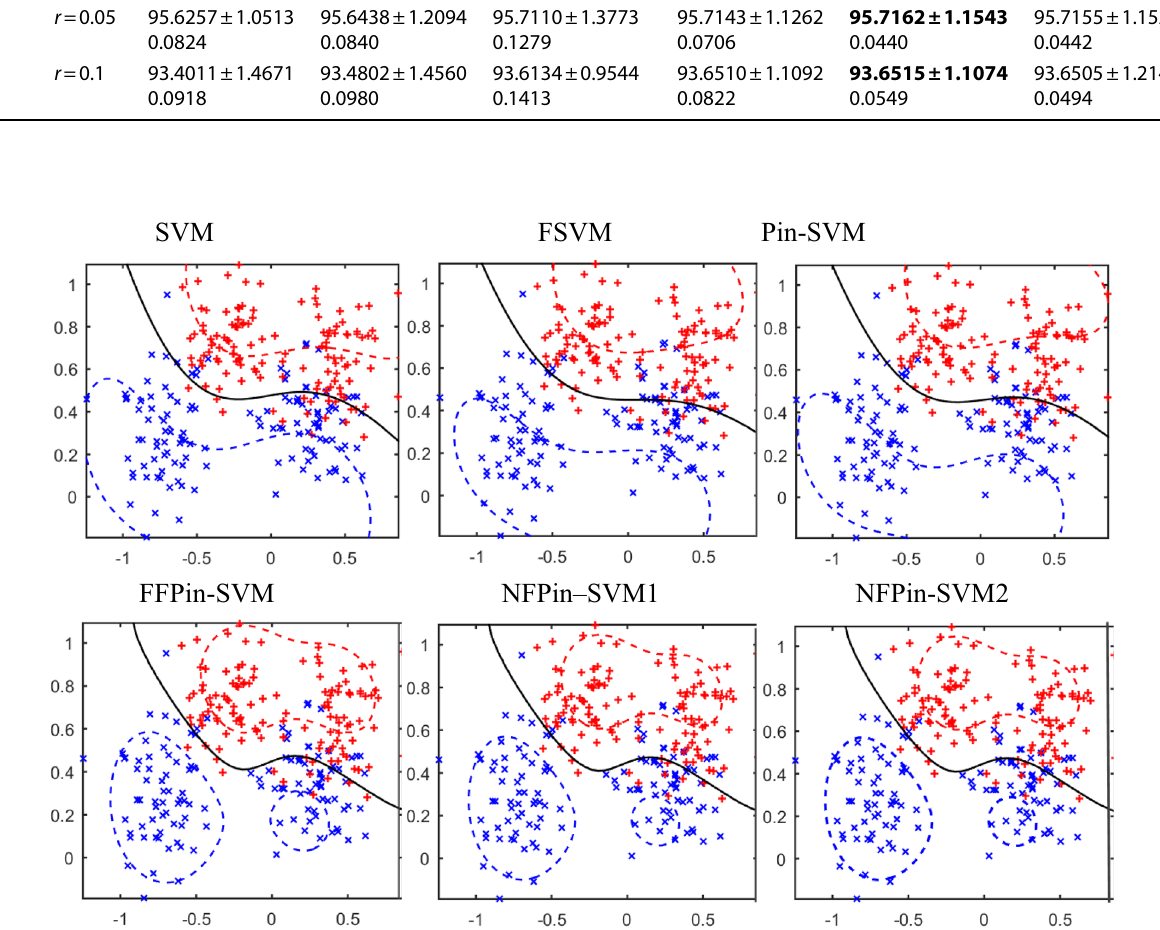
Fig. 2 Classification results of the out proposed methods FFPin-SVM, NFPin-SVM1, and NFPin-SVM2 with nonlinear Pin-SVM, FSVM, and SVM on Example 2 (Ripley’s dataset)